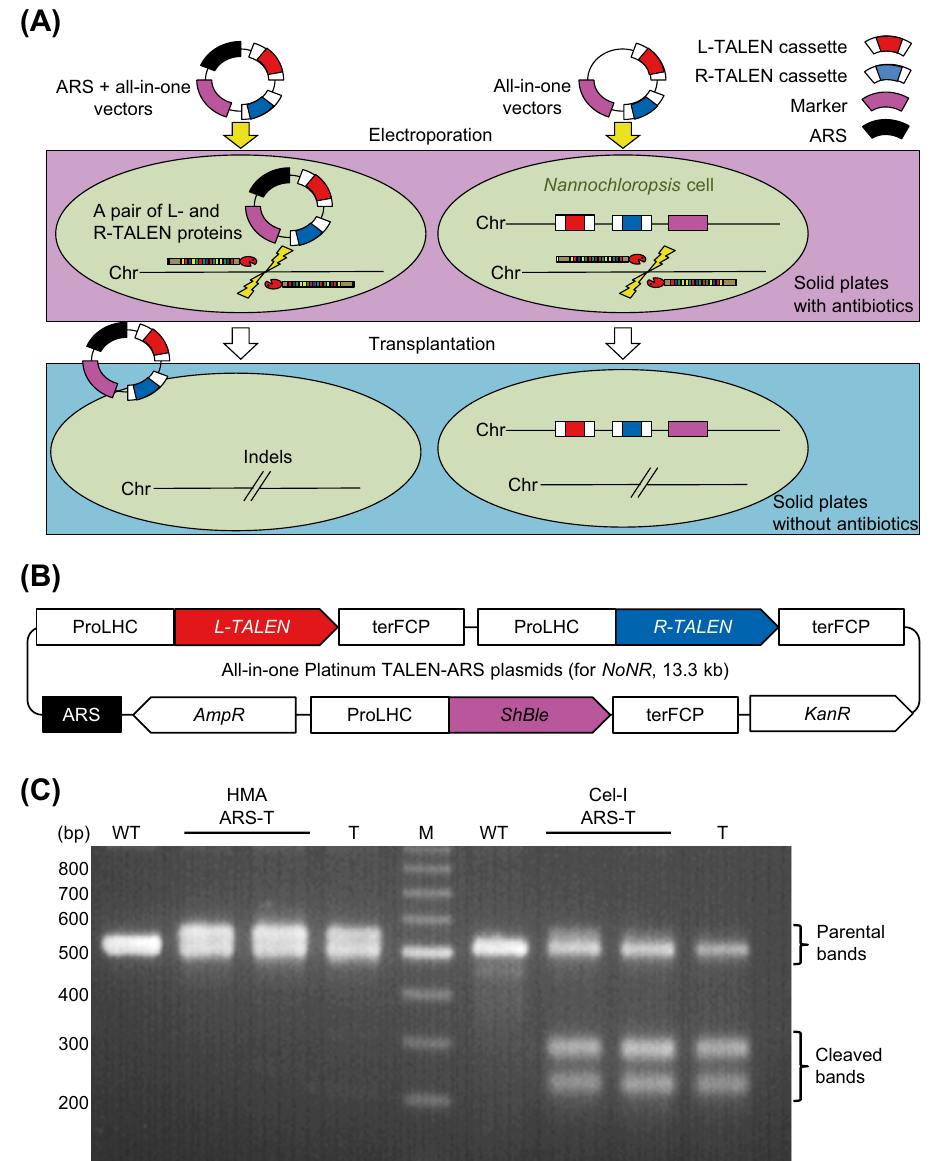
Figure 1. Construction of all-in-one PtTALEN-ARS plasmids and verification of genome editing activity. ( A ) Workflow of transgene-free genome editing using all-in-one PtTALEN-ARS plasmids. The plasmids containing CEN/ARS are not inserted into the chromosome and can be removed after mutagenesis. Chr: chromosome. ( B ) Schematic diagram of all-in-one PtTALEN-ARS plasmids. These plasmids have two antibiotic genes, AmpR and KanR . These are facilitated to construct the all-in-one TALEN-ARS vectors. ProLHC: LHC promoter; terFCP: FCP terminator; L-TALEN: left TALEN; R-TALEN: right TALEN; AmpR : ampicillin resistance